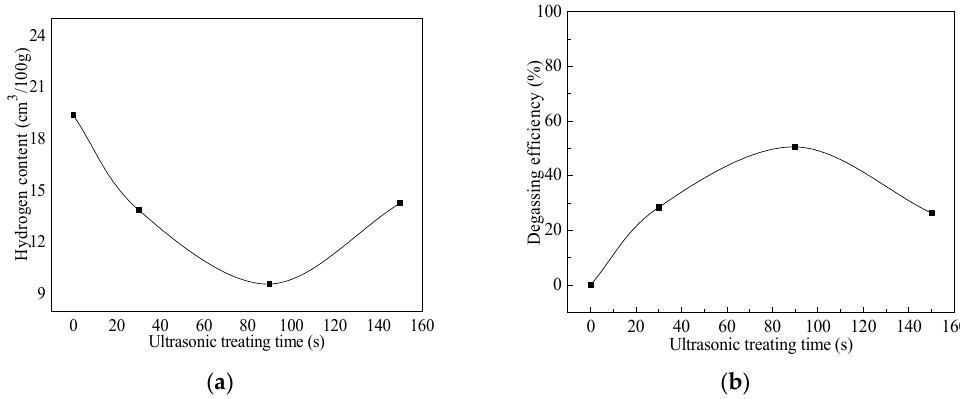
Figure 10. Variation of hydrogen content and degassing efficiency in AZ91 alloy by ultrasonic treating time. ( a ) hydrogen content; ( b ) degassing efficiency.